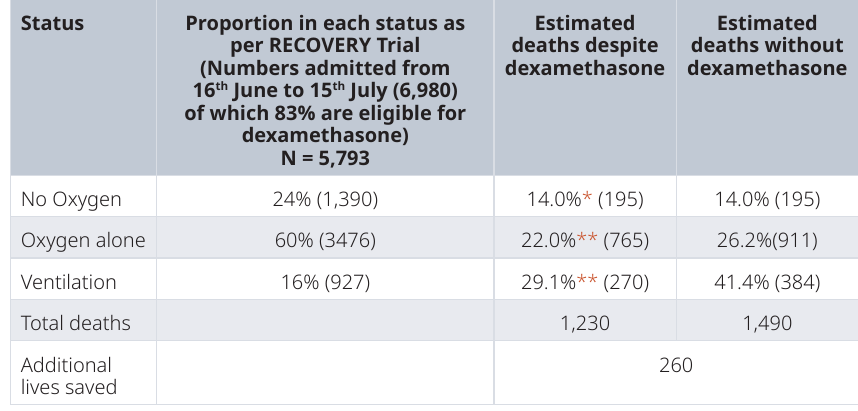
Table 1. Estimated numbers of additional patients who survived up to 15 th July due to